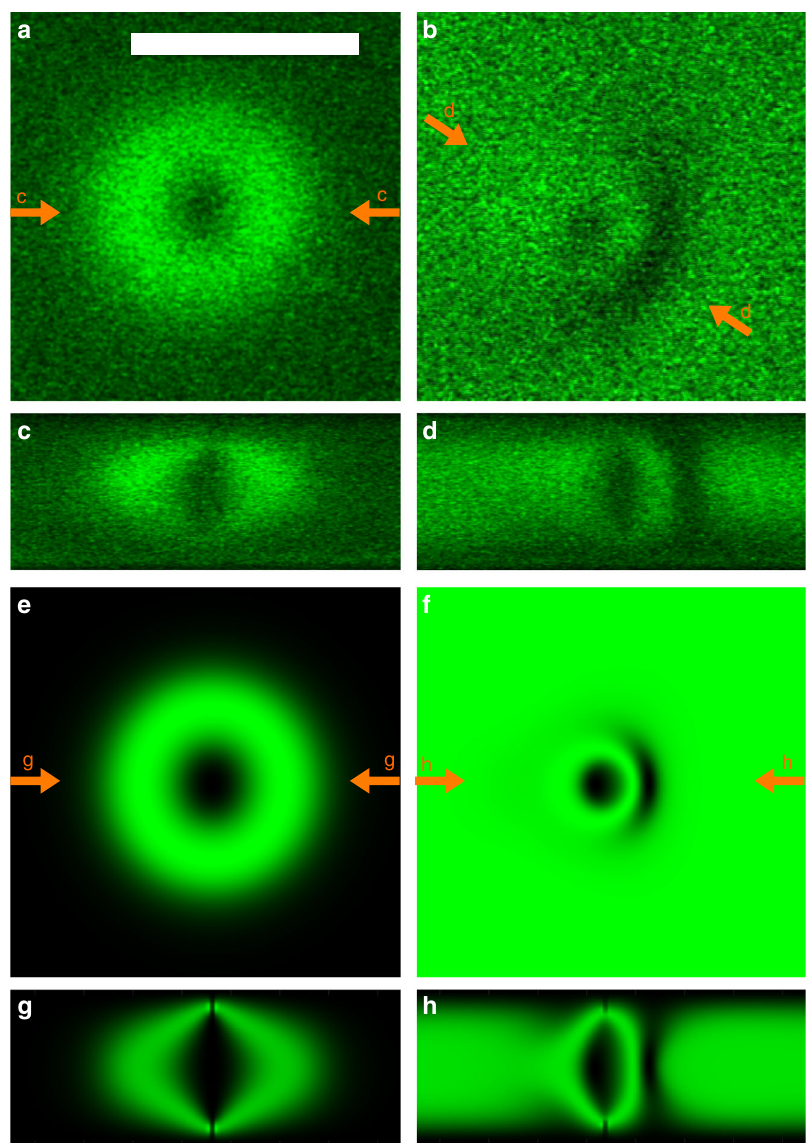
Fig. 4 3PEF-PM images of baby skyrmions. a , b Experimental 3PEF-PM images of the director structure of the skyrmion in the cross-sectional plane orthogonal to the skyrmion's axis and parallel to substrates for ( a ) U = 0 V and ( b ) U = 4 V. f c = 1 kHz. The scale bar in a is 10 µ m and applies to images ( a – d ). c , d The corresponding experimental 3PEF-PM images of the director structure of the-skyrmion obtained in the vertical cross-sectional plane parallel to the normal to cell substrates and passing through the skyrmion ’ s center for ( c ) U = 0 V and ( d ) U = 4 V. e – h The corresponding computer simulated 3PEF- PM images of the skyrmion in the ( e , f ) plane perpendicular to n 0 and ( g , h ) vertical cross-sections parallel to n 0 . The 3PEF-PM excitation light used in imaging was circularly